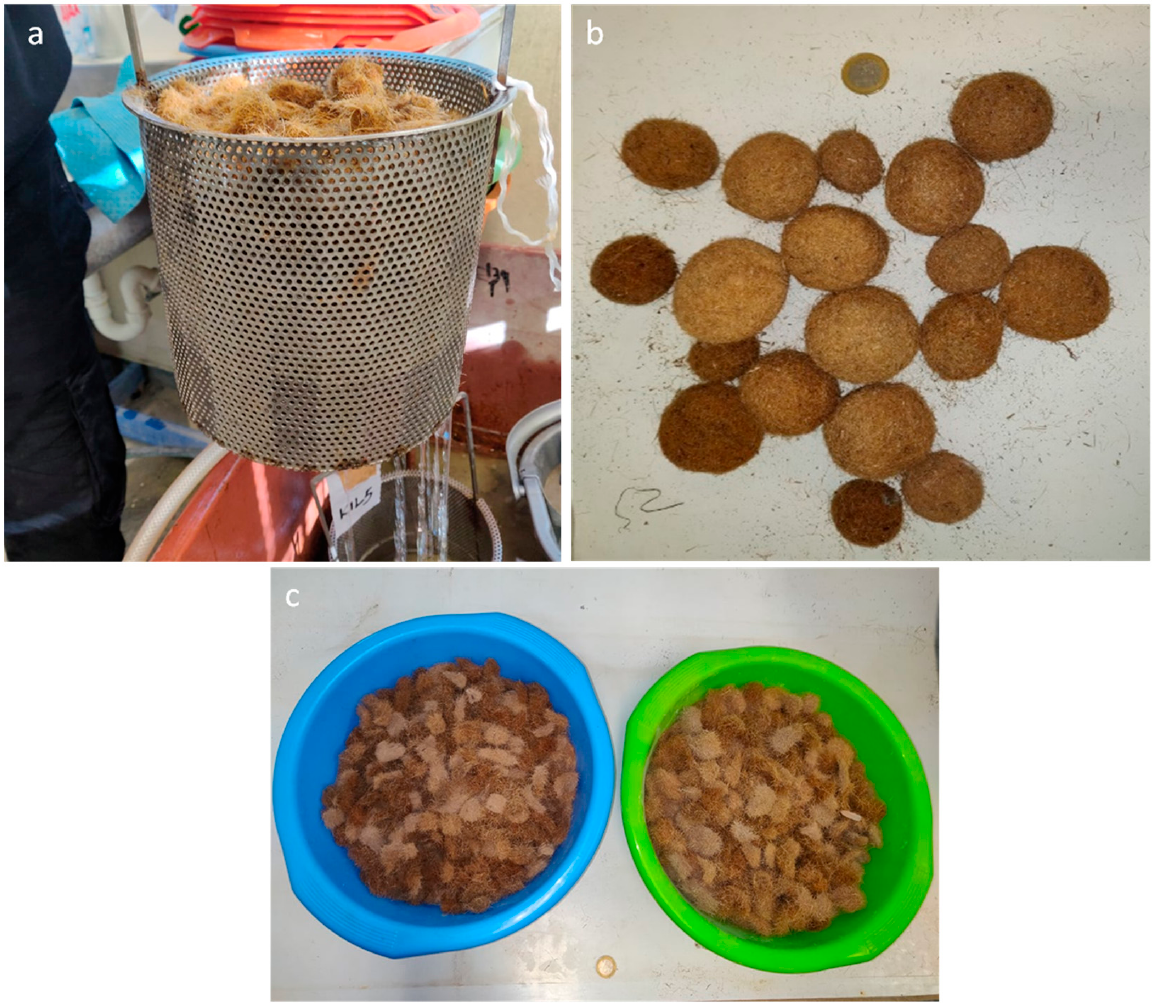
Figure 2. ( a , b ) Posidonia oceanica and drying ball samples as the raw material, and ( c ) the samples after washing.